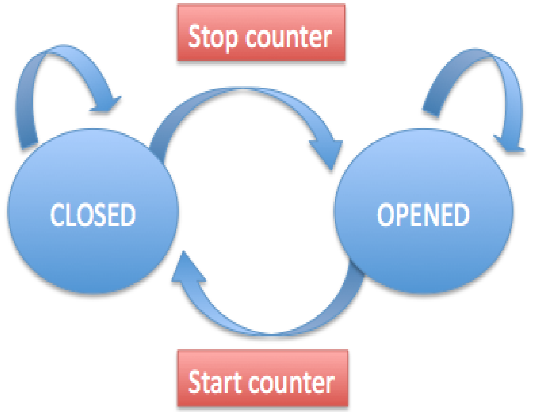
Figure 9. Flow chart for blinkControl algorithm filtering.